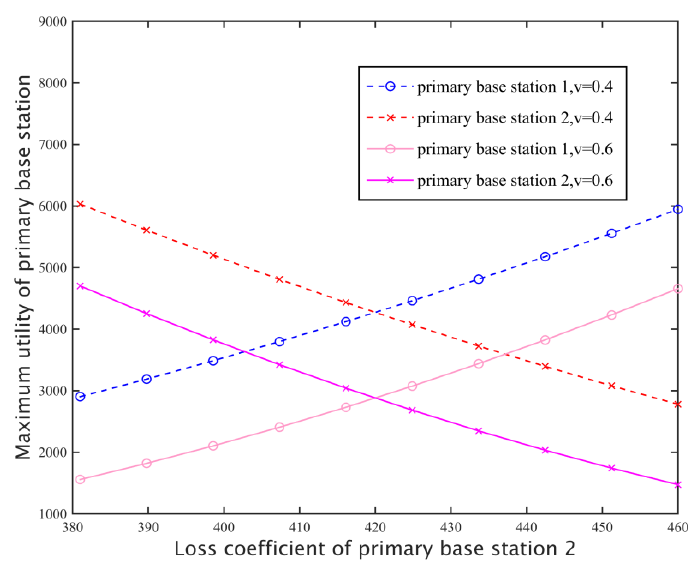
Figure 11. Maximum revenue of the primary base station.